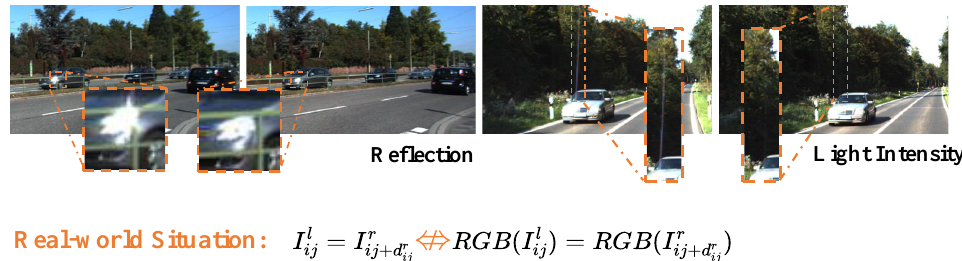
Figure 1. Illustration of the color constancy hypothesis problem in previous self-supervised depth estimation task, where I l and I r represent the left and right view, d r represents the disparity map of the right view, ij represents the coordinates on an image, and RGB represents the RGB value on each